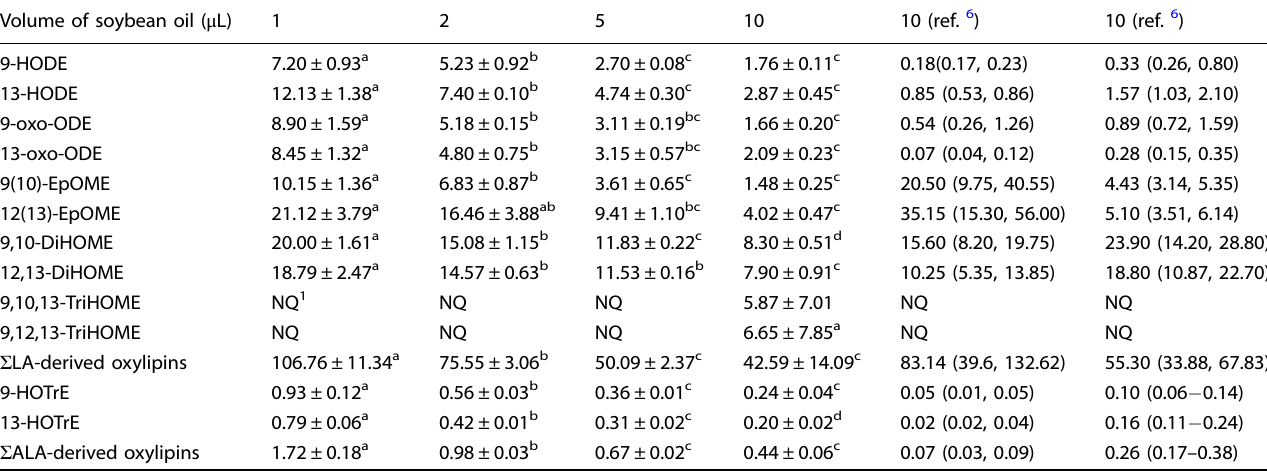
Table 1. Concentrations of total linoleic acid (LA)-derived and α -linolenic acid (ALA)-derived oxylipins in different volumes of soybean oil (pmol/ μ L). Volume of soybean oil ( μ